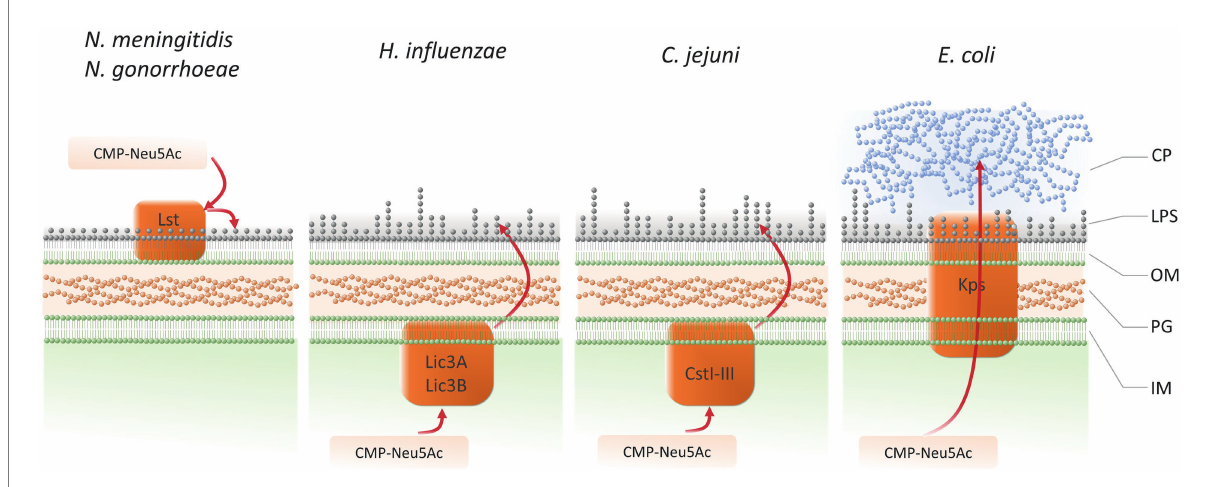
FIGURE 4 Pathways for deploying sialic acid on bacterial pathogens cell surface: Neisseria meningitidis , Neisseria gonorrhoeae (Shell et al., 2002; Lewis et al., 2015), Haemophilus influenzae (Jessamine and Ronald, 1990; Fox et al., 2006), Campylobacter jejuni (Chiu et al., 2007), Escherichia coli (Shen et al., 1999; Vimr et al., 2004; Severi et al., 2007). IM, inner membrane; PG, peptidoglycan; OM, outer membrane; LPS, lipopolysaccharide; CP, capsular polysaccharide.